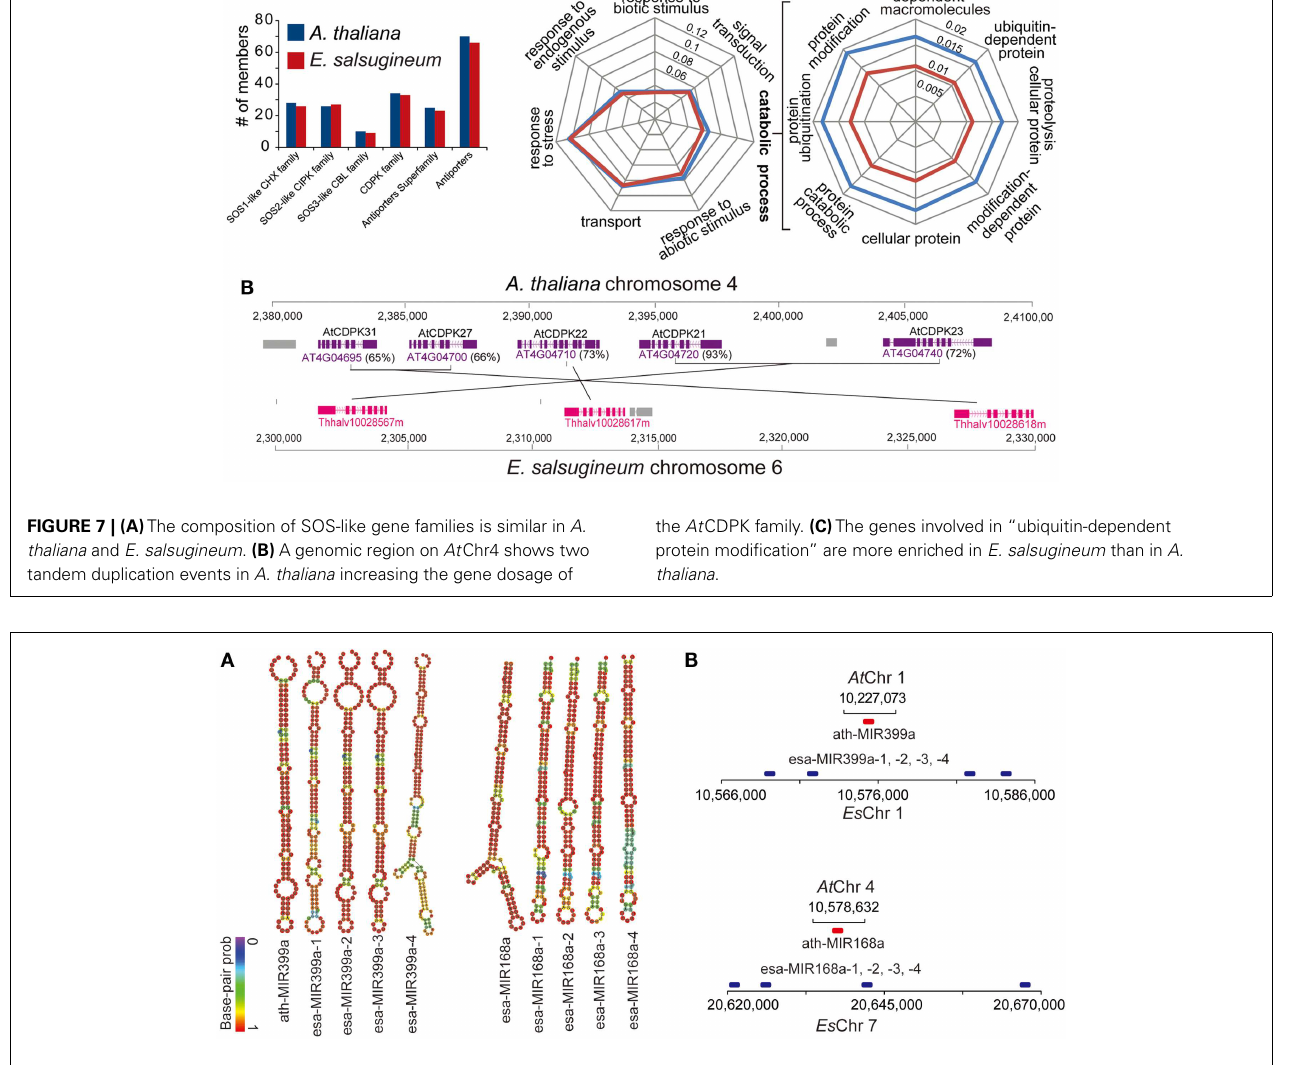
FIGURE 8 |Tandemly duplicated stress-related miRNAs in E. salsugineum. (A) The hairpin structures of ath-MIR399a and ath-MIR168a in A. thaliana , and the four copies of esa-MIR399a and esa-MIR168a miRNA